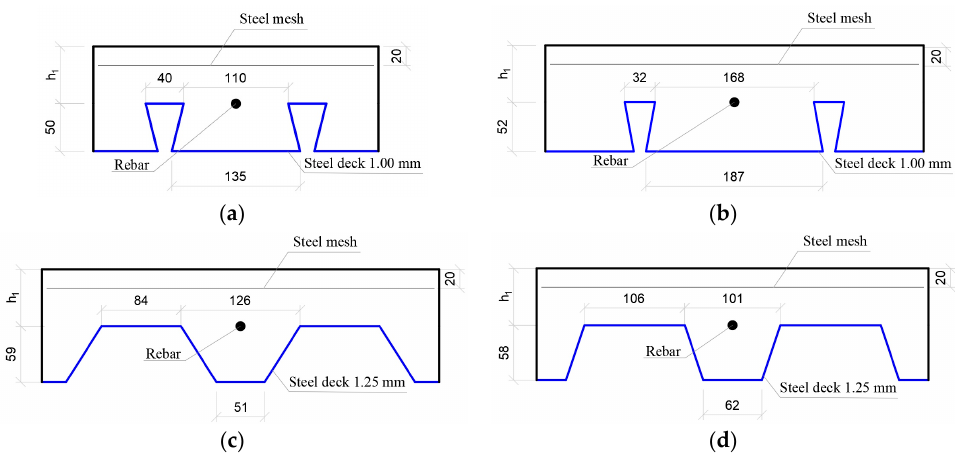
Figure 4. Commercial steel deck profiles used in the parametric study for different values of h 1 , with measures in millimetres: ( a ) Multideck 50; ( b ) Bondeck; ( c ) Polideck 59S; ( d ) Confraplus 60.